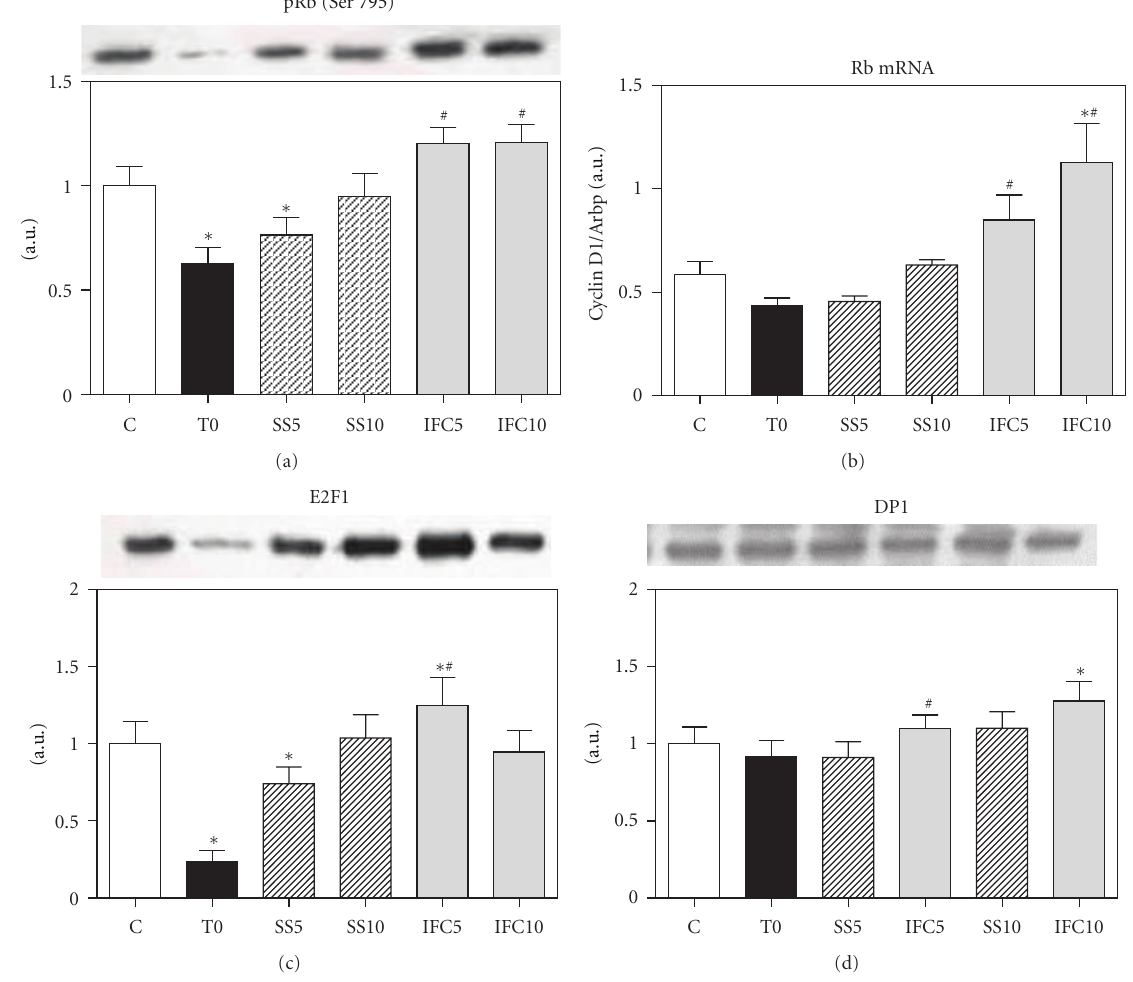
Figure 4: E ff ect of IFC305 treatment on phospho-Rb (Ser 795), E2F1, and DP1 proteins expression in cirrhotic livers. (a), (c), and (d) Expression of the indicated proteins from liver nuclear extracts was done by western blot analysis. A representative western blot image of each one is shown. The bar graph represents the densitometry analysis expressed as arbitrary units of the mean ± SEM from 3rats/group; values were normalized to β -actin immunodetection (image, Figure 1(a)). ∗ Statistical di ff erence ( P < 0 . 05) when compared to C group. # Statistical di ff erence ( P < 0 . 05) when compared to their respective experimental group SS5 or SS10. (b) E ff ect of IFC305 treatment on Rb mRNA expression in CCl 4 -induced cirrhosis in rats. RNA was isolated from liver and mRNA expression for Rb was analyzed by quantitative RT-PCR as described in Section 2. Arbitrary units were normalized with Arbp mRNA gene expression level. Data represent mean ± SEM from 3rats/group. ∗ Statistical di ff erence ( P < 0 . 05) compared to C group. # Statistical di ff erence ( P < 0 . 05) when compared to their respective experimental group SS5 or